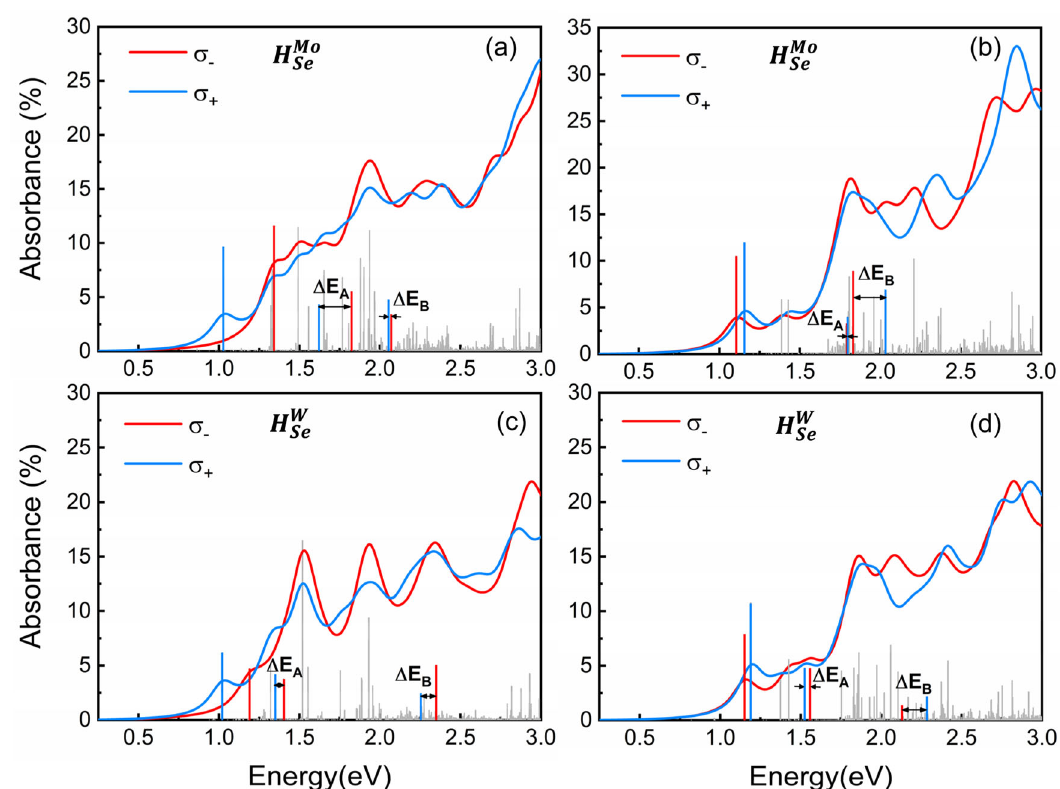
Fig. 6 The absorption spectra and excitonic oscillating strength of H M stacked MSe 2 /VSe 2 . Optical absorbance spectra excited by Se left - handed σ + and right - handed σ − light for H Mo stacked MoSe 2 /VSe 2 heterostructures within GW-BSE@PBE ( a ) and GW-BSE@HSE ( α = 0.06, Se μ = 0.2 Å − 1 ) ( b ), for H W stacked WSe 2 /VSe 2 within GW-BSE@PBE ( c ) and GW-BSE@HSE ( α = 0.09, μ = 0.2 Å − 1 ) ( d ). The vertical grey vertical line Se indicates the oscillating strength of each exciton for in-plane polarized light absorption, while the blue and red vertical lines highlight the low- energy bright excitons from K and − K valleys.